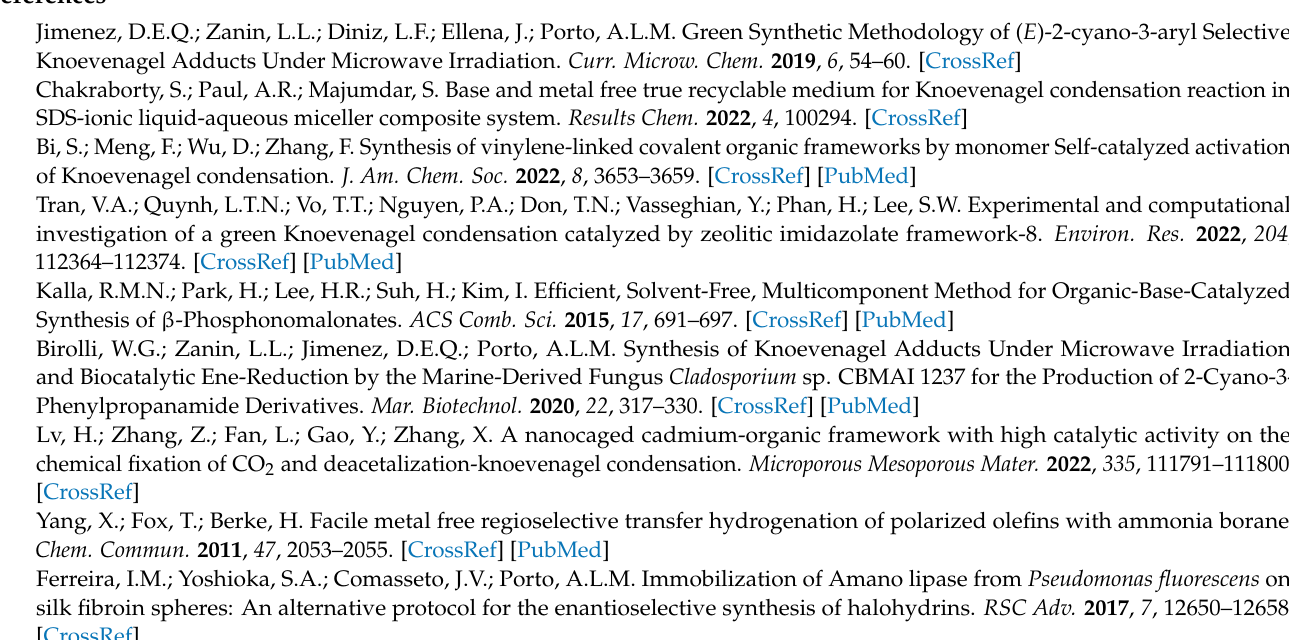
ne)malononitrile 2h , Figure S31: FT-IR of 2-(4-bromobenzylidene)malononitrile 2h , Figure S32: MS (70 eV) of 2-(4-bromobenzylidene)malononitrile 2h , Figure S33: 1 H NMR (500 MHz, CDCl 3 ) of 2-(4-hydroxybenzylidene)malononitrile 2i , Figure S34: 13 C NMR (125 MHz, CDCl 3 ) of 2-(4- hydroxybenzylidene)malononitrile 2i , Figure S35: FT-IR of 2-(4-hydroxybenzylidene)malononitrile 2i , Figure S36: MS (70 eV) of 2-(4-hydroxybenzylidene)malononitrile 2i , Figure S37: 1 H NMR (500 MHz, CDCl 3 ) of 2-(4-nitrobenzylidene)malononitrile 2j , Figure S38: 13 C NMR (125 MHz, CDCl 3 ) of 2- (4-nitrobenzylidene)malononitrile 2j , Figure S39: FT-IR of 2-(4-nitrobenzylidene)malononitrile 2j , Figure S40: MS (70 eV) of 2-(4-nitrobenzylidene)malononitrile 2j , Figure S41: 1 H NMR (400 MHz, CDCl 3 ) of 2-(4-cyanobenzylidene)malononitrile 2k , Figure S42: 13 C NMR (100 MHz, CDCl 3 ) of 2-(4- cyanobenzylidene)malononitrile 2k , Figure S43: FT-IR of 2-(4-cyanobenzylidene)malononitrile 2k , Figure S44: MS (70 eV) of 2-(4-cyanobenzylidene)malononitrile 2k , Figure S45: 1 H NMR (400 MHz, CDCl 3 ) of (2-methyl-3-phenylallylidene)malononitrile 2l , Figure S46: 13 C NMR (100 MHz, CDCl 3 ) of (2-methyl-3-phenylallylidene)malononitrile 2l , Figure S47: FT-IR of 2-(3-phenylallylidene)malononitri le 2l , Figure S48: MS (70 eV) of 2-(3-phenylallylidene)malononitrile 2l